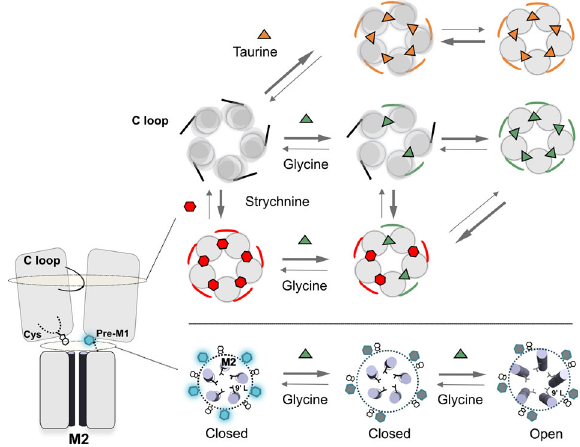
Fig. 8 | Hypothetical transition pathway of the GlyR. Left panel: side-view car- toon representation of two subunits of the GlyR. C loop contributing to the orthosteric site, the quenching sensor, the TAMRA (hexagon), and tryptophane (indole) are represented. Upper panel: top view representation of the receptor in different conformations with the ECD of each subunitshown in a circle and C loop asa line. Lower panel: top view representation of the TMD showing the M2 helices and the L9 ’ that closes the pore in the resting and intermediate(s) conformations. The black circle represents positions where the fl uorescent-quenching sensor is grafted. The indole goes closer to the TAMRA from the resting to the inter- mediate(s) conformations, generating a quenching of fl